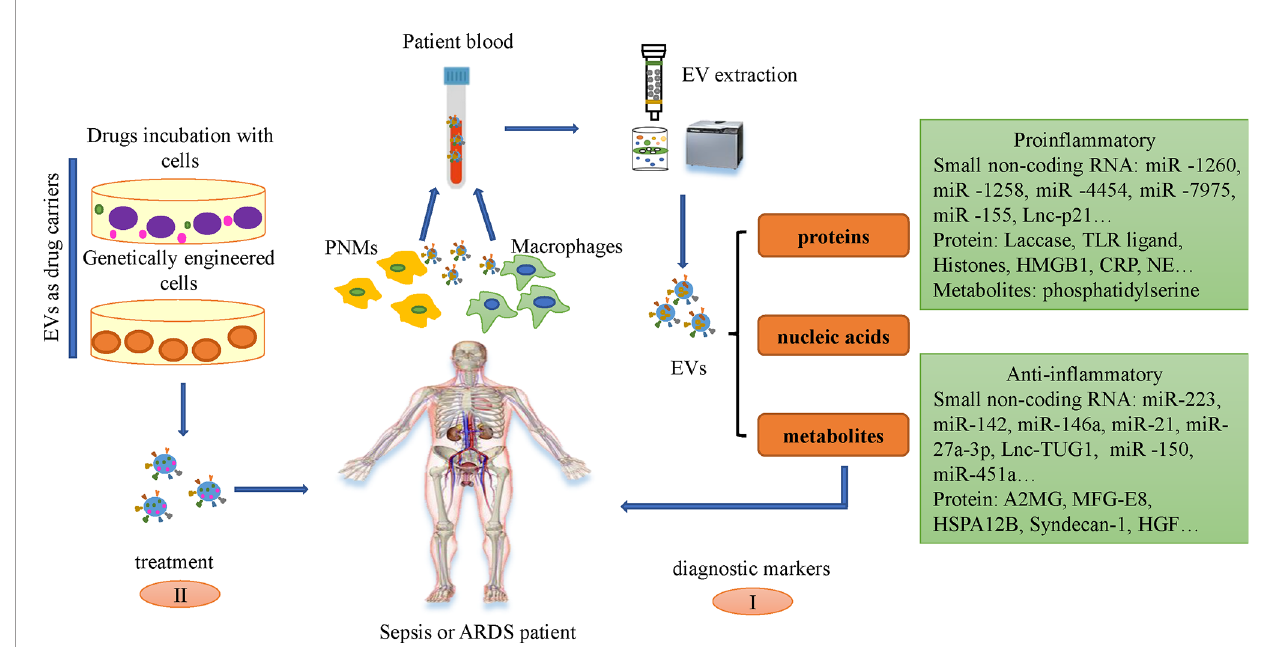
FIGURE 2 | Application of EVs in sepsis and ARDS. I. Small non-coding RNAs and proteins in the serum EVs of patients with sepsis and ARDS can be used as diagnostic markers. II. EVs could be engineered and employed as drug delivery vehicles for downstream treatment via two different ways: incubate the drugs with the cells to produce drugs-loaded EVs and engineer the genetic characteristics of cells through genetic remodeling, making EVs with designed bio-active